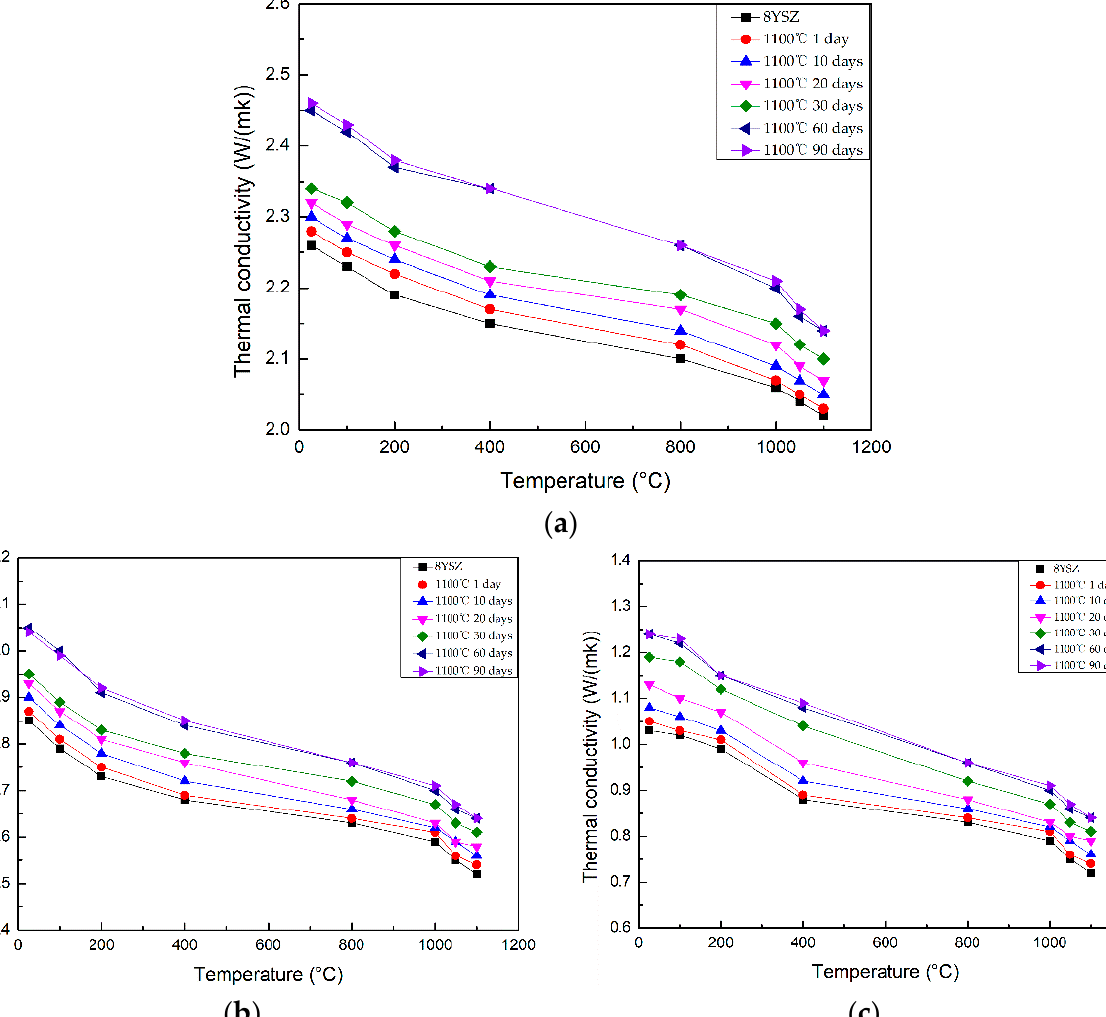
Figure 14. The tested thermal conductivities of the top coats in TBCs with different porosities at 1100 °C for different serving times: ( a ) 0%; ( b ) 10%; ( c ) 15%.